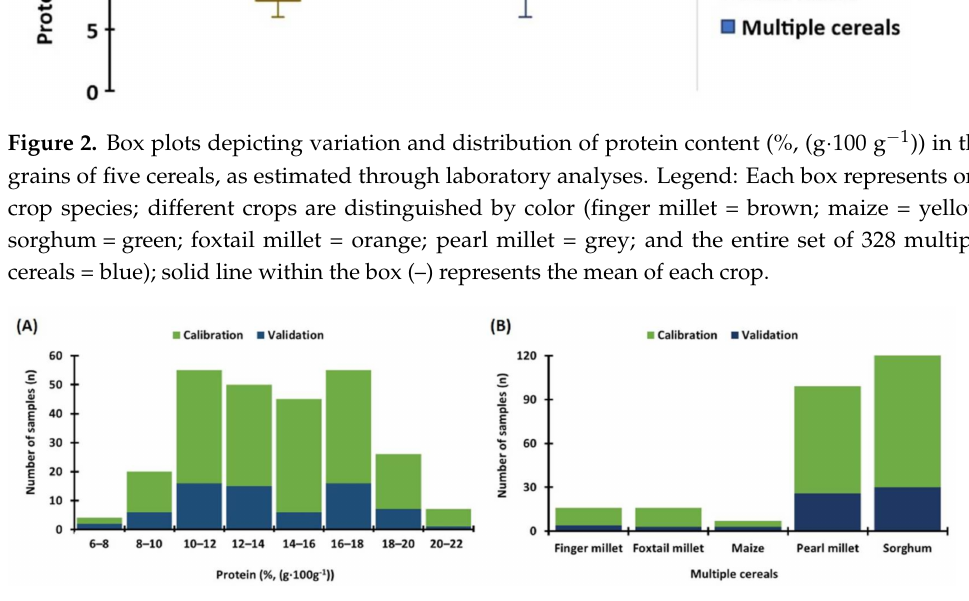
Figure 3. Histograms depicting the distribution of ( A ) the protein content (%, (g · 100 g − 1 )) in samples, and ( B ) the number of samples used within each of the crop species belonging to the calibration (80%) and validation (20%)